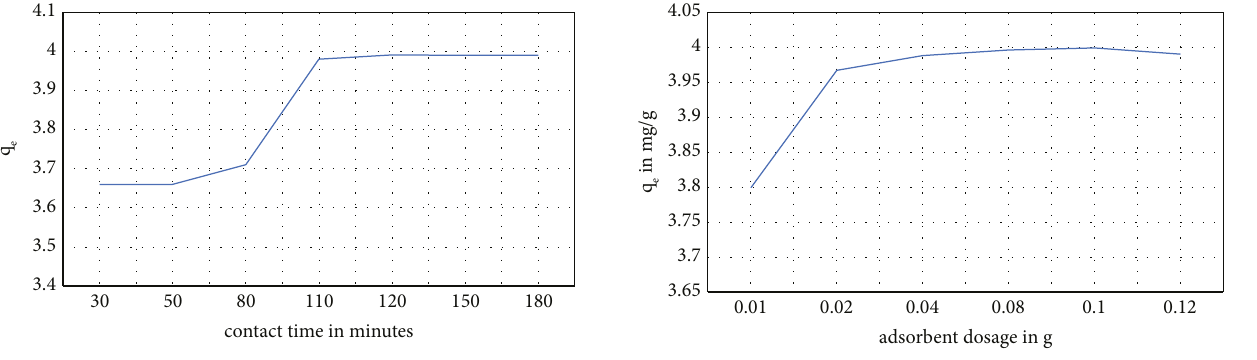
Figure 19: Effect of adsorbent dosage on the adsorption of dieldrin onto nanocomposite (initial concentration 20 ppm, pH � 7.0, contact time � 120min).